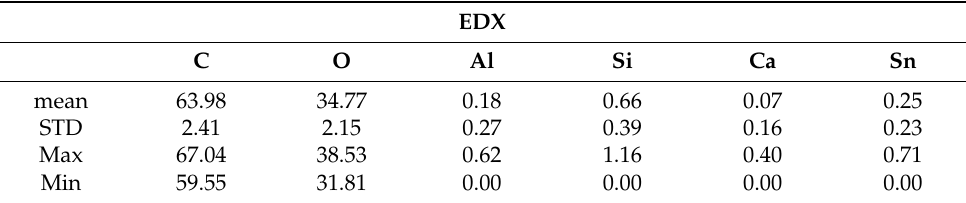
Figure 3. Microstructure of the unpolished dark sample’s surface with areas for EDX analysis. Table 2. Average chemical composition of the unpolished dark sample’s surface by EDX in